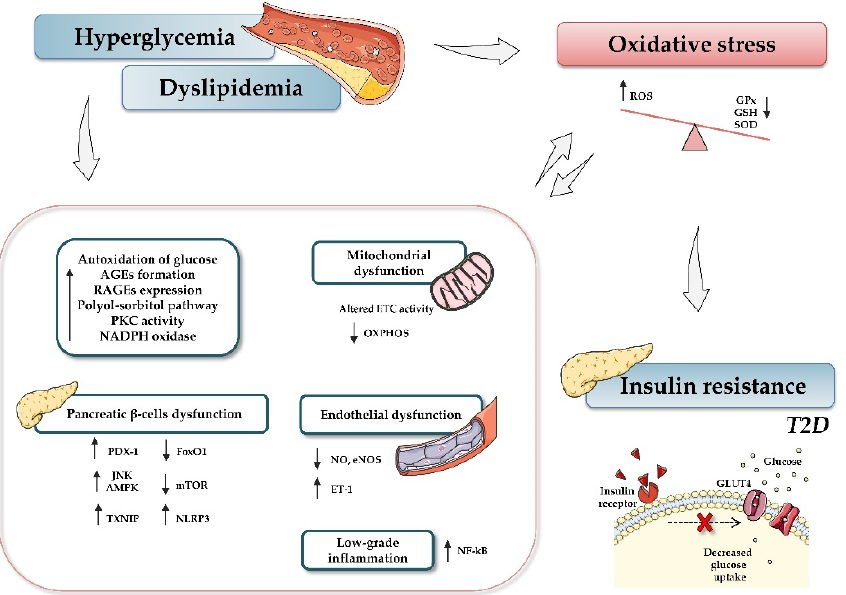
Figure 1. Relationship between type 2 diabetes and oxidative stress. Hyperglycemia, dyslipidemia, and insulin resistance play key roles in oxidative stress and diabetes development. Briefly, increased glucose levels promote different mechanisms, such as autoxidation of glucose, accumulation of advanced glycation-end products (AGE) and nitric oxide (NO), activation of diacylglycerol (DAG), activation of polyol-sorbitol pathway, and an increase in protein kinase C (PKC), which, in turn, lead to the generation of oxidative stress, impairment of mitochondrial function, and induction of inflammatory events. The figure summarizes the most relevant involved processes and signaling pathways. Up and down arrows indicate an increase and decrease, respectively. Abbreviations: AGEs, advanced glycation-end products; AMPK, AMP-activated protein kinase; ETC, electron transport chain; FoxO1, Forkhead box protein O1; GPx, glutathione peroxidase; GSH, reduced glutathione; NADPH, nicotinamide adenine dinucleotide phosphate; NF- к B, nuclear factor kappa-light-chain-enhancer of activated B cells; NO, nitric oxide; eNOS, endothelial nitric oxide synthase; mTOR, mammalian target of rapamycin; NLRP3, (nucleotide oligomerization domain (NOD), leucine-rich repeat (LRR) and pyrin domain (PYD)); OXPHOS, oxidative phosphorylation system; PDX-1, pancreatic and duodenal homeobox 1; PKC, protein kinase C; RAGEs, receptor for AGEs; ROS, reactive oxygen species; SOD, dismutase; JNK, c-Jun N-terminal kinase; T2D, type 2 diabetes; TXNIP, thioredoxin-interacting protein.